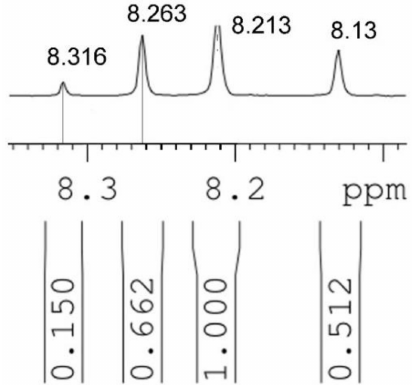
Figure 2. The 1 H-NMR spectrum in CDCl 3 of the Csp 3 -H proton of the crude mixture (integration in the vertical scale)